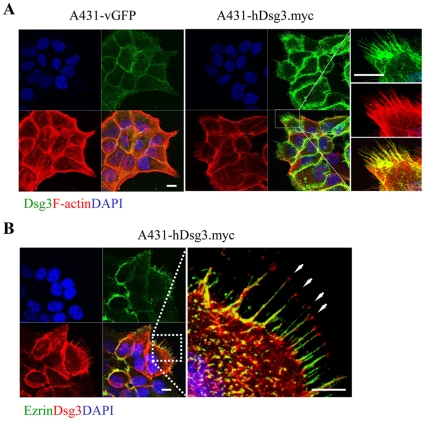
Formation of filopodia by hDsg3.myc cells.(A) Dual labelling of Dsg3 (green) and F-actin (red) in A431 stable lines shows marked filopodium formation in the hDsg3.myc cells. (B) Co-localisation with ezrin (green) established the filopodial nature of these protrusive structures with Dsg3 expression (red) at the tips of each filopodium (arrowheads). Bars, 10 µm.